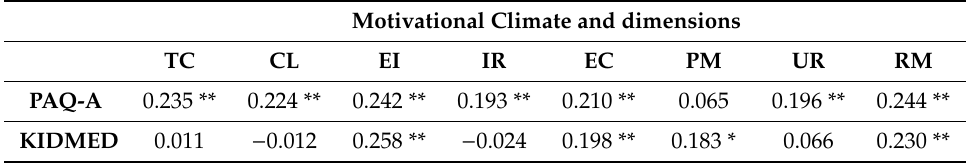
Table 3. Correlation coe ffi cients between motivational climate, physical activity level, and